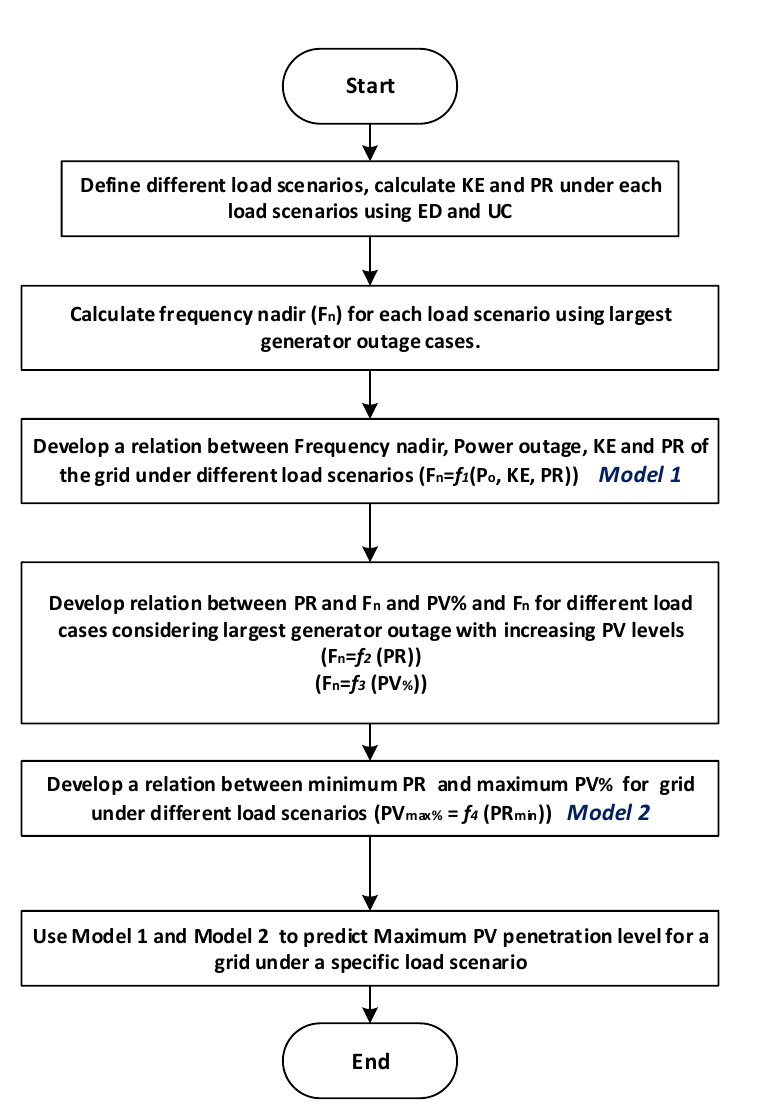
Figure 8. Flowchart for frequency nadir-based PV max% estimation.